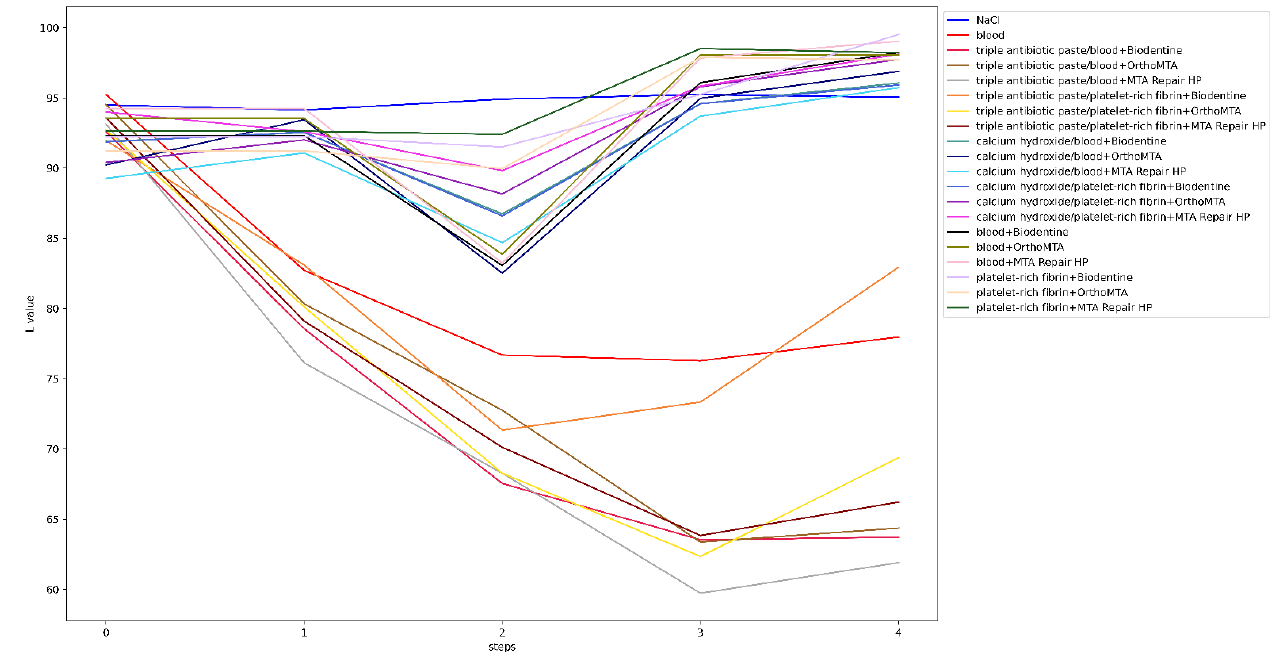
Figure 5. Values of ∆L for all groups and steps.